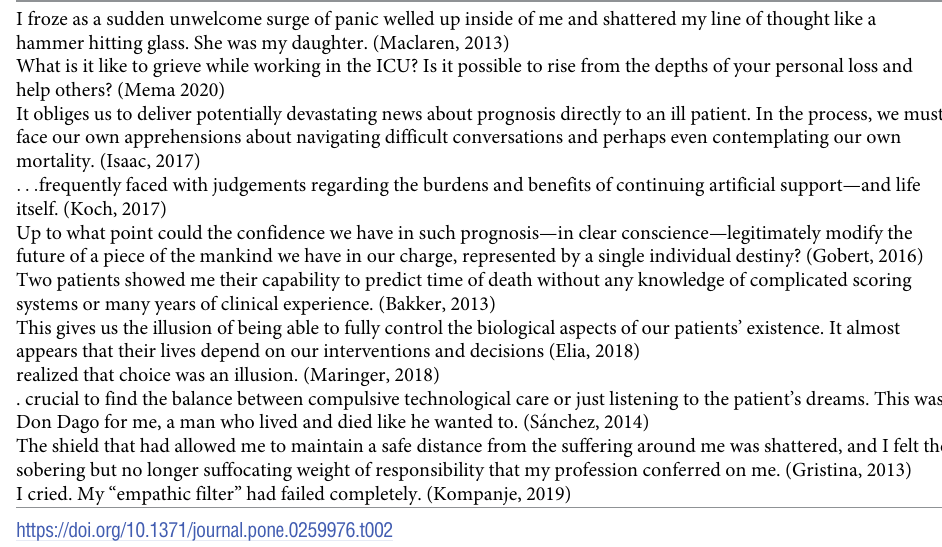
Table 2. Quotation for the sub-theme 1: Role